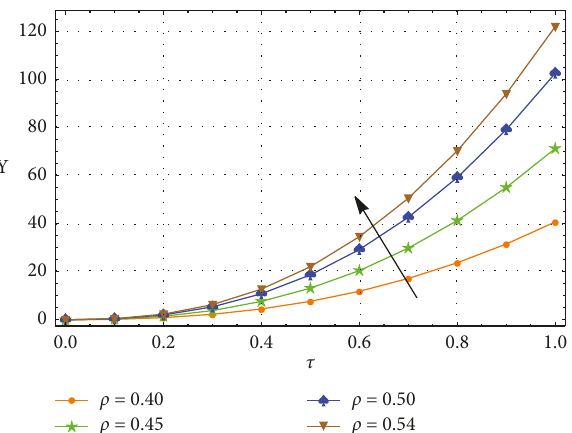
Figure 12: Effect of ρ on solution profile in Example 3 at α � 0.5 and x �